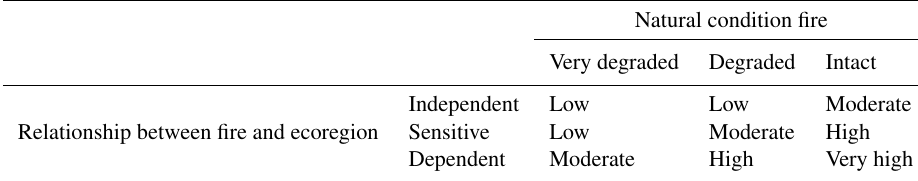
Natural condition fire Very degraded Degraded Intact Independent Low Low Sensitive Low High Very high